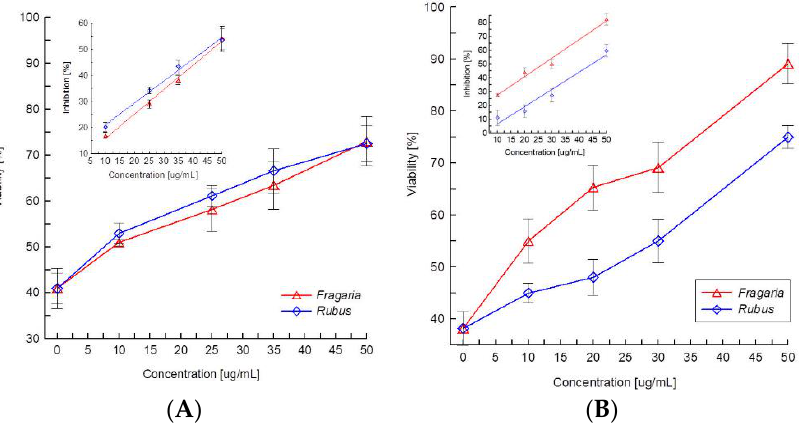
Figure 7. Viability (%) of HMEC-1 cells oxidized by 7.5 µM of AAPH for 24 h in the presence of different concentrations of extracts from Rubus and Fragaria leaves. ( A ) Viability was calculated on the basis of results obtained in MTT assay, ( B ) viability was calculated on the basis of results obtained in Hoechst 33342 assay. The dependences of the inhibition (%) of HMEC-1 cells oxidation on the concentration of tested extracts calculated from results of MTT ( A ) and Hoechst 33342 ( B ) assays are shown as the inserted figures.